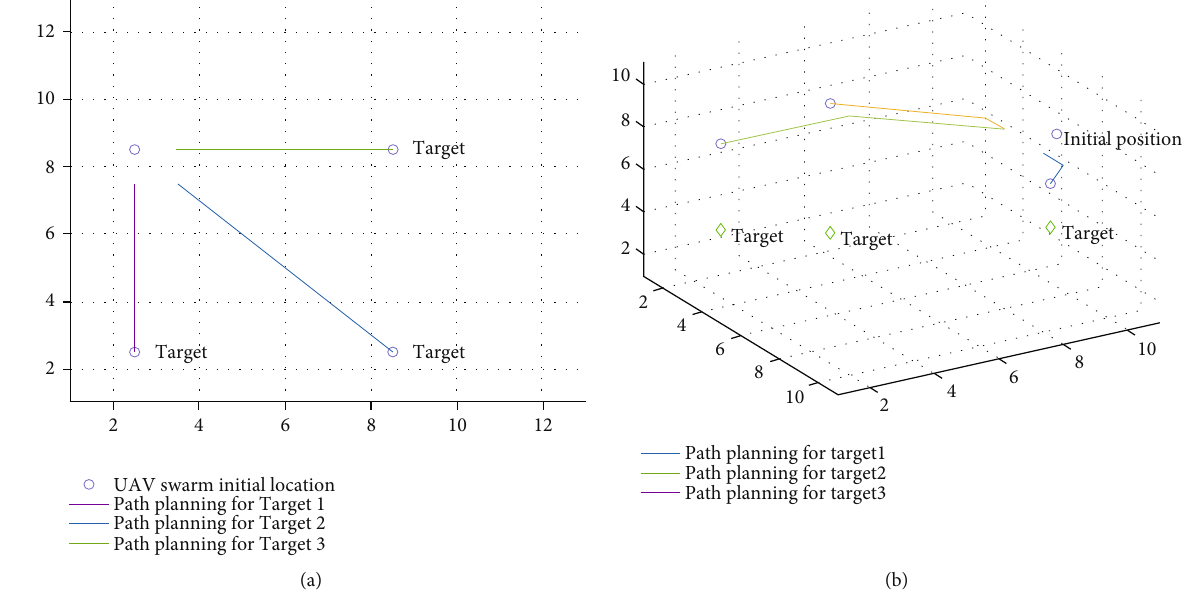
Figure 5: 2D (a) and 3D (b) task assignment examples for drone swarm. Table 1: Result